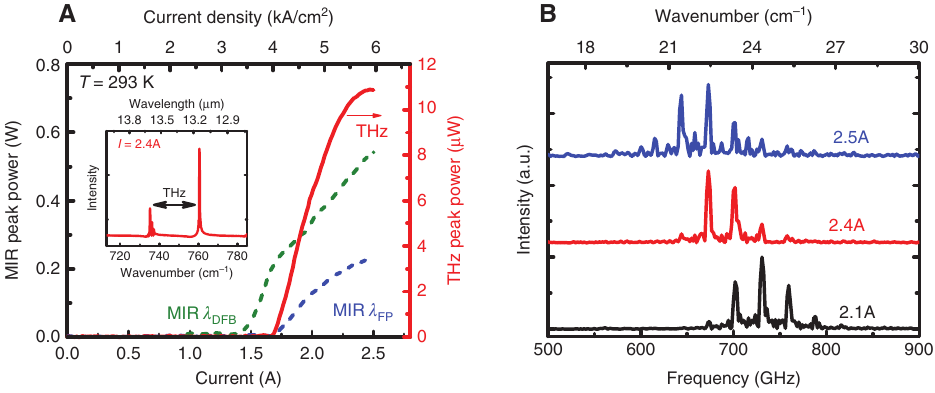
Figure 2: Room-temperature performance of a sub-THz source. (A) Current-light output characteristics of a 3.0-mm-long, 14- μ m-wide buried heterostructure device for THz peak power and MIR pump powers. The dashed blue line is the FP emission centered at 760 cm −1 and the dashed green line is DFB emission at 735 cm −1 . The laser was operated at room temperature with 200-ns pulses at 50 kHz. The room-temperature MIR emission spectrum is shown in the inset. (B) Room-temperature THz emission spectra at various